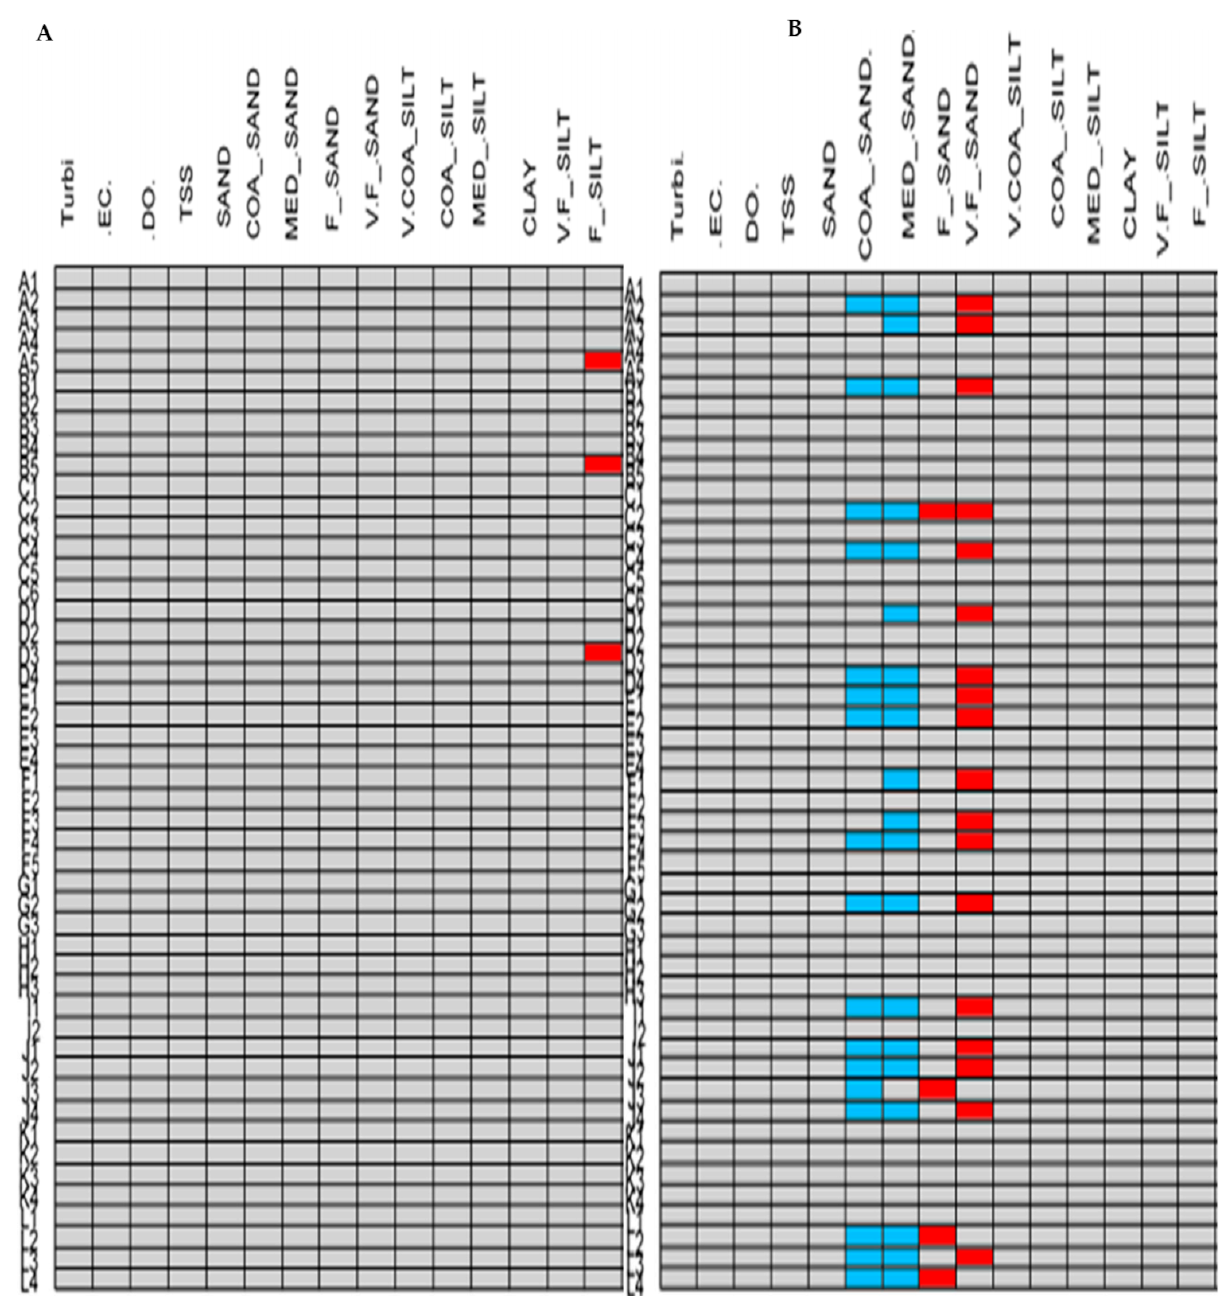
Figure 3. Results of the fourth corner analysis showing the correlations between macroinvertebrates traits/ecological preferences, and the fine suspended sediments grain sizes as well as selected physico-chemical variables in the Tsitsa River and its tributaries during the dry season ( A ) and wet season ( B ). Red indicates a significant positive correlation ( p ≤ 0.05) and blue indicates significant negative correlation ( p ≤ 0.05); grain sizes and physico-chemical variables: Turb: turbidity, EC: electrical conductivity, TSS: total suspended solids, F_SAND: fine sand, COA_SAND: coarse sand, MED_SAND: medium sand, VF_SAND: very fine sand, V.COA_SILT: very coarse silt, COA_SILT: coarse silt, MED_SILT: medium silt, F_SILT: fine silt and VF_SILT: very fine